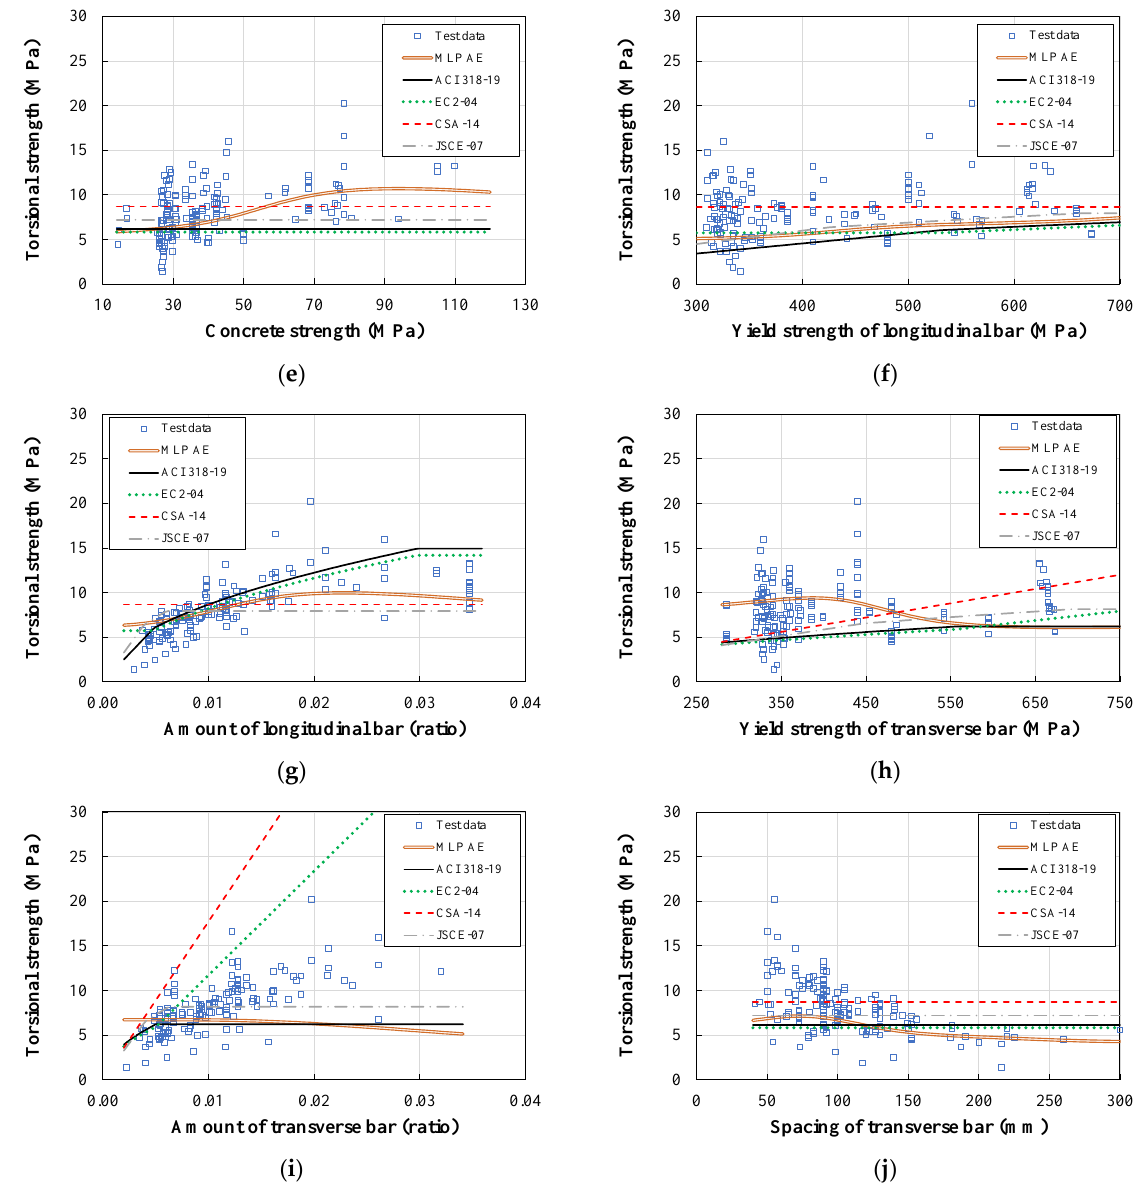
Figure 6. Parametric study using autoencoder: ( a ) beam width; ( b ) beam height; ( c ) closed beam width; ( d ) closed beam height; ( e ) concrete strength; ( f ) yield strength of longitudinal bar; ( g ) amount of longitudinal bar; ( h ) yield strength of transverse bar; ( i ) amount of transverse bar; ( j ) spacing of transverse bar.